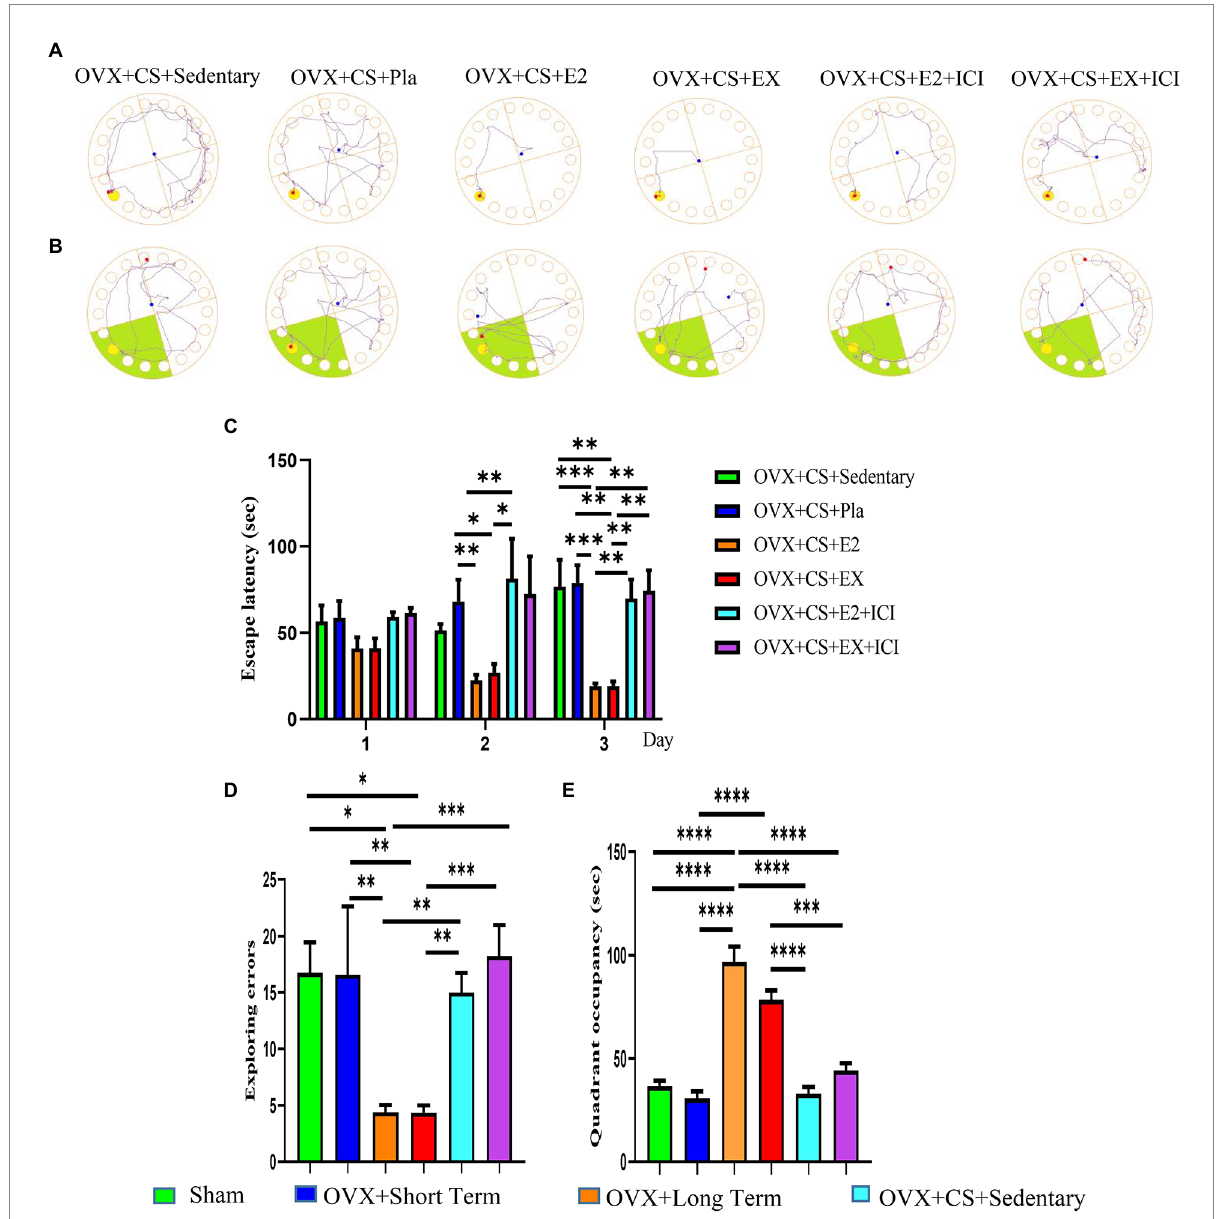
FIGURE 6 Both aerobic exercise and estrogen effectively regained learning memory function in depressed rats, while the beneficial treatment effects of aerobic exercise were inhibited by the administration of estrogen receptor antagonists. Representative graphs of the activity trajectories of each group of rats in the Barnes maze during the training period (A) and the exploration period (B) . Comparative analysis of latency time (C) within and between groups during the training period (days 1 to 3) and the number of errors in exploring the escape box (D) , and dwell time in the target quadrant (E) between groups 5during the exploration period. All data are expressed as mean ± SEM ( n = 8–12). * P < 0.05, ** P < 0.05, *** P < 0.001, **** P <